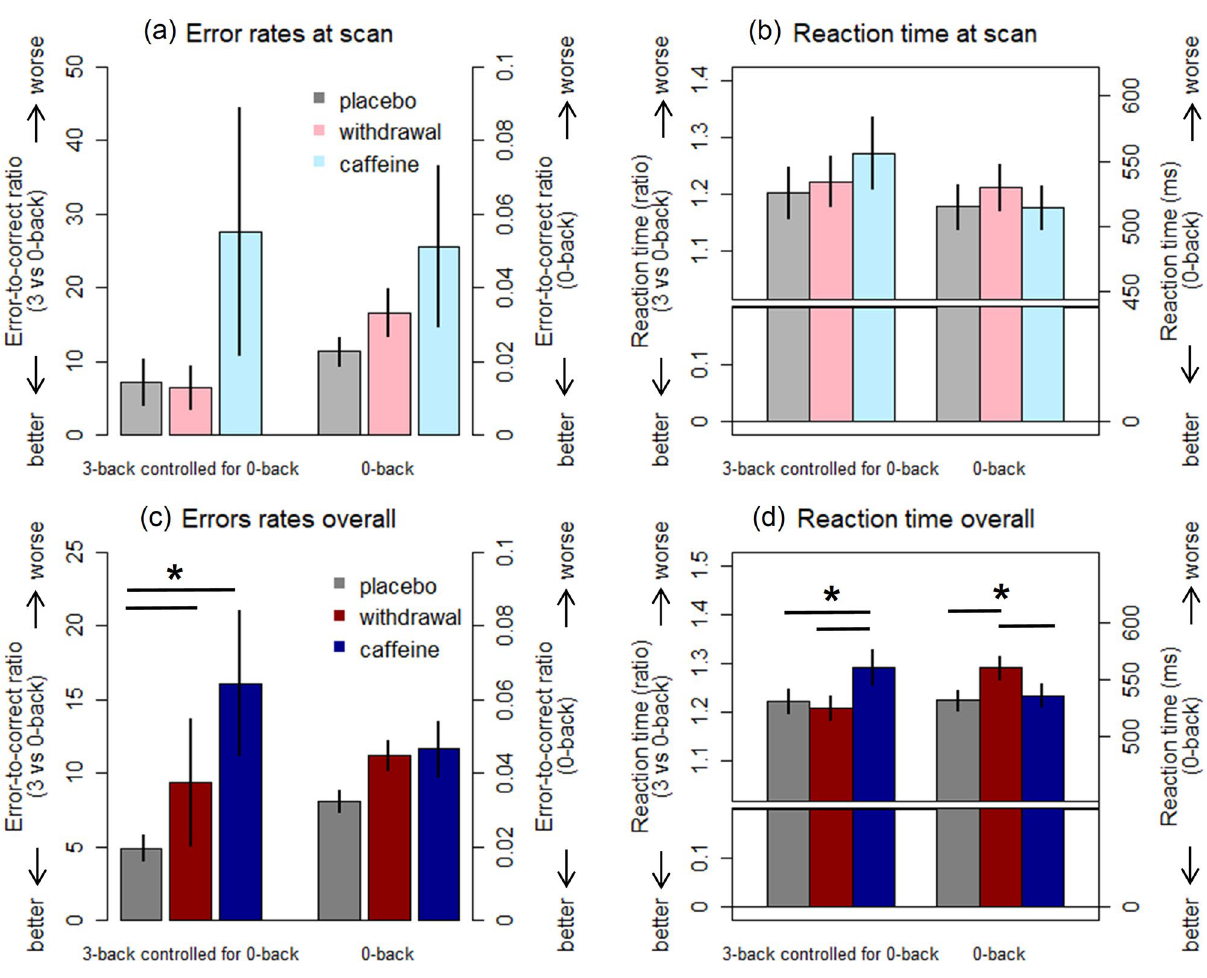
Figure 2. Main effect and time course of N-back performance per condition. (a,b) display the main effects of conditions at scan session with means and standard errors of the error rates (left panel) and the reaction time (RT, right panel). The three bars on the left side of each plot presents the performance in 3- proportional to 0-back, while the other three on the right side of each presents the performance in 0-back tasks. In an identical fashion, ( c , d ) display the main effects of conditions over all four sessions. We omit separated displays by sessions since the condition effects did not significantly differ between sessions (i.e. no significant interaction effects; please see "Result"section). However, we provide a separate panel for the performance at the scan session, i.e. ( a , b ), which allows integrating the behavioral information with the fMRI results. Note: in this visualization, we use the proportions of 3- to 0-back to adjust the performance of 3-back for 0-back. In statistics, we used raw data of 3-back as the outcome variables and regressed out the variance of 0-back in a linear mixed